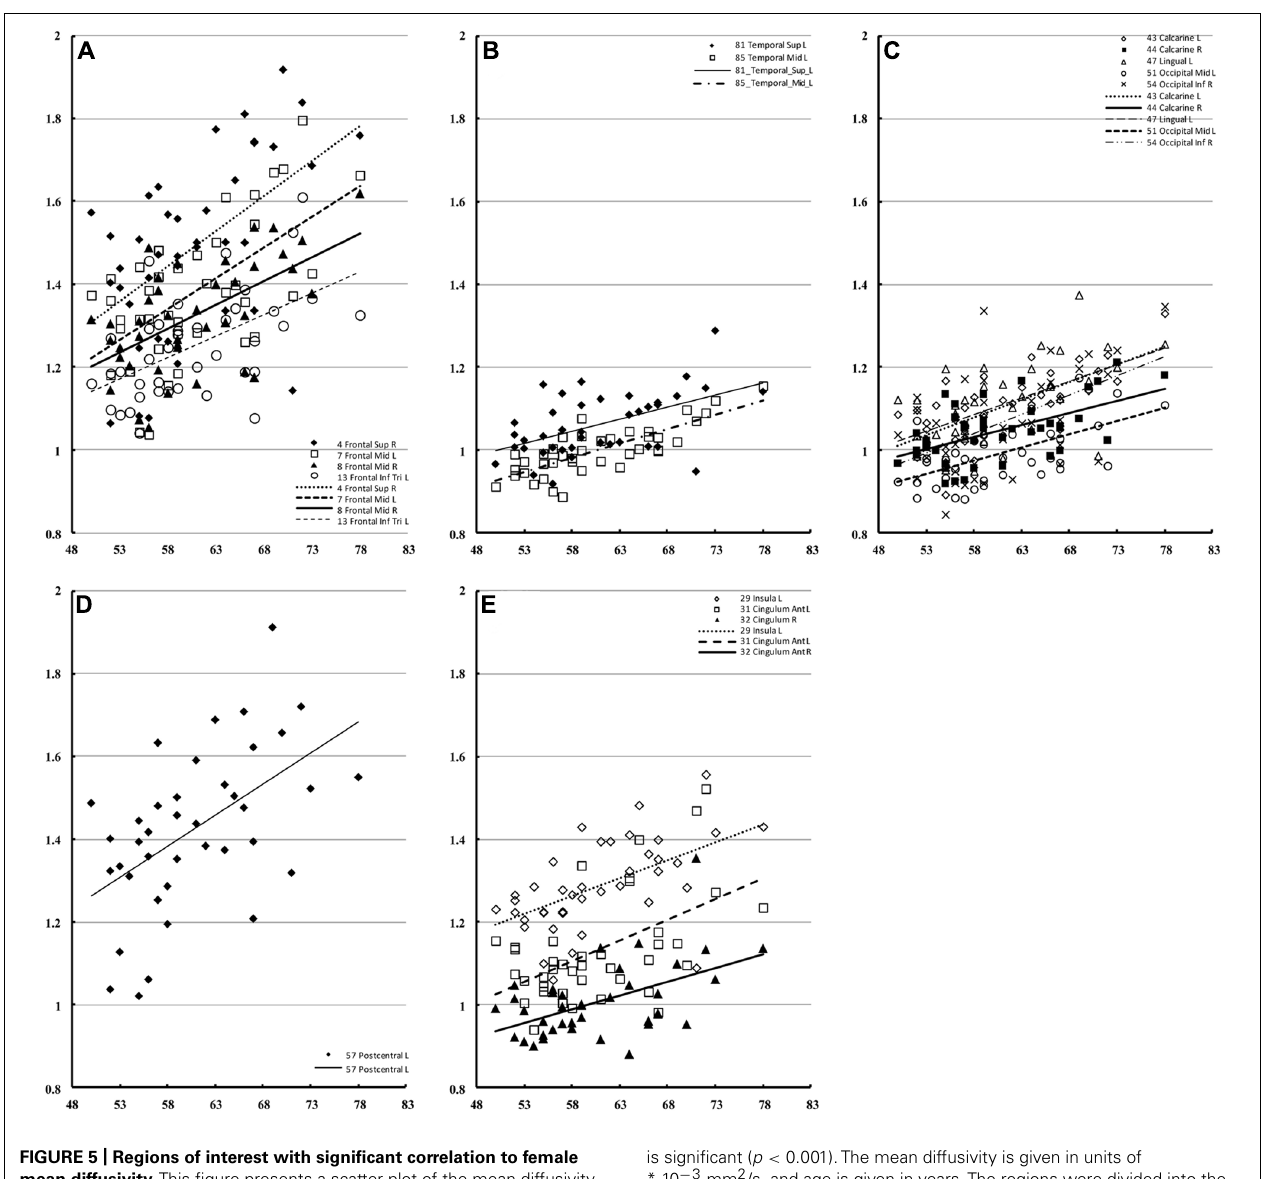
is significant ( p < 0.001).The mean diffusivity is given in units of * 10 − 3 mm 2 /s, and age is given in years.The regions were divided into the frontal (A) , temporal (B) , occipital (C) , parietal (D) , and additional regions (E) .